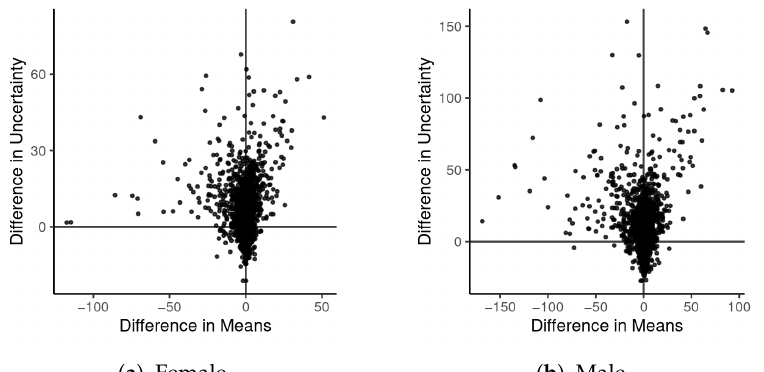
(cid:0) λ · P (cid:1) for the full HBM and the 100,000